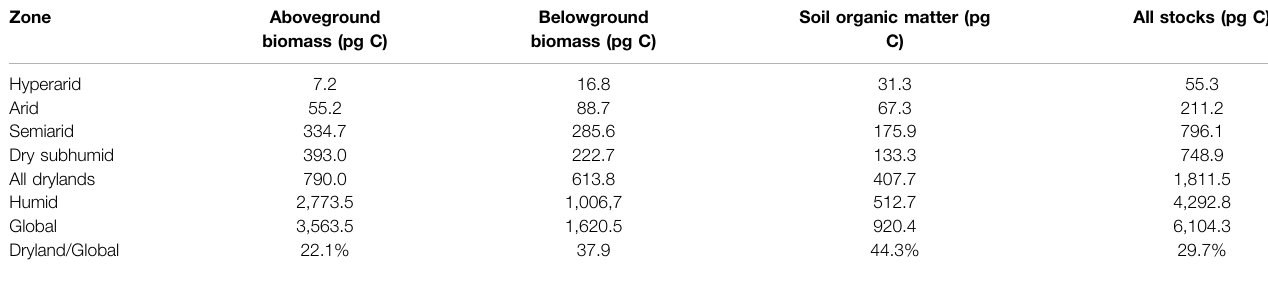
TABLE 1| Estimatesoftotalcarbon (C)inglobaldrylands,summarizingdatafrom Figure2 forthearidityzones identi fi edin Figure1 .TheSpawn andGibbs,2020biomass analyses are derived from data on above-ground wood and below-ground root biomass, with modelled/calibrated estimates of average carbon in